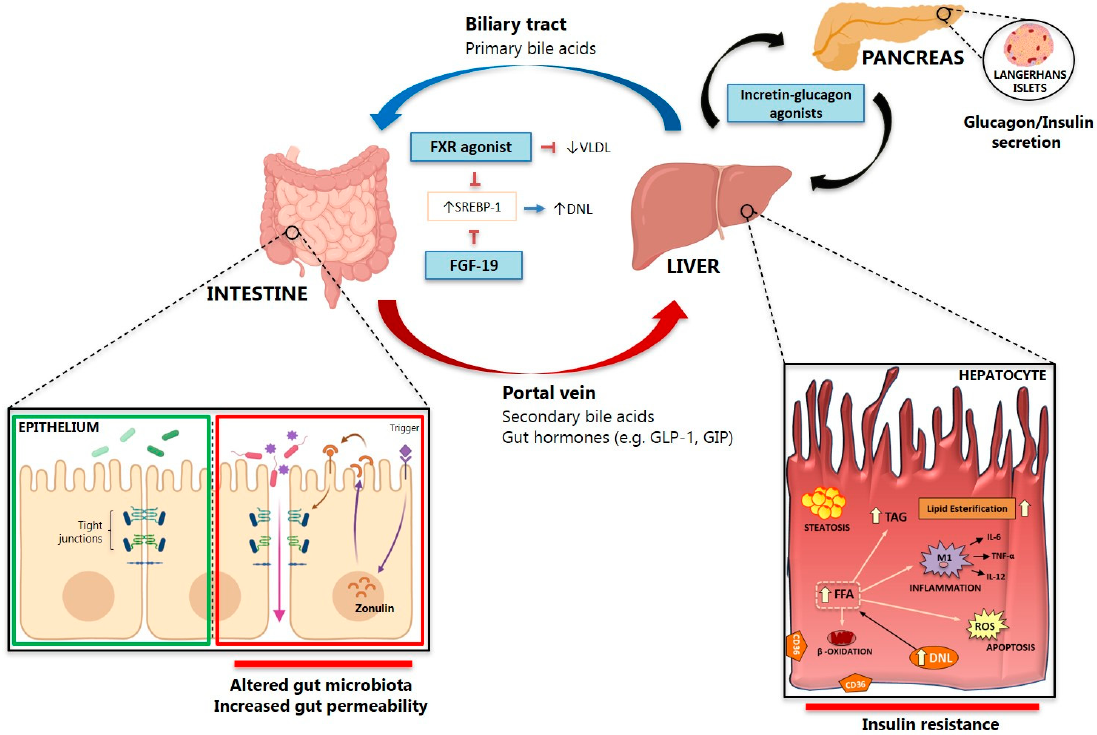
Figure 3. The gut-pancreas-liver axis in the context of non-alcoholic fatty liver disease (NAFLD). The intestine and the liver are in constant communication through the portal vein and the biliary tract. In the intestine, the maintenance of the intestinal endothelial cell barrier achieved through tight junctions is crucial. In pathological conditions, an alteration in the diversity and composition of gut microbiota could lead to the secretion of harmful bacterial products, which consequently damages the intestinal epithelium by disrupting tight junctions. Another mechanism that has been indicated to explain increased intestinal permeability is zonulin, a protein secreted within intestinal cells upon a trigger (e.g., gluten), which is thought to be responsible for tight junction disassembling. In such conditions, harmful bacteria / bacterial products cross the intestinal wall and reach the liver via portal circulation, where they activate toll-like receptors (TLRs) on hepatocyte cell surface, promoting steatosis, inflammation, apoptosis, and insulin resistance. The intestine is also responsible for the secretion of the incretin hormones GLP-1 and GIP upon nutrient stimulation, which go through the liver, reach circulation, and target the pancreas to regulate insulin and glucagon secretion. On the other hand, the liver secretes primary bile acids into the intestine to aid digestion, which are converted into secondary bile acids by gut microbiota, and the majority are reabsorbed back to the liver. A rearrangement in the gut-pancreas-liver axis has been hypothesized to play a role in the pathogenesis and development of NAFLD. Abbreviations: CD36, Cluster of di ff erentiation 36; DNL, de novo lipogenesis; FFA, Free fatty acids; GIP, Glucose-dependent insulinotropic peptide; GLP-1, Glucagon-like peptide-1; IL, Interleukin; ROS, Reactive oxygen species; TAG, Triglycerides; TNF- α , Tumor necrosis factor α